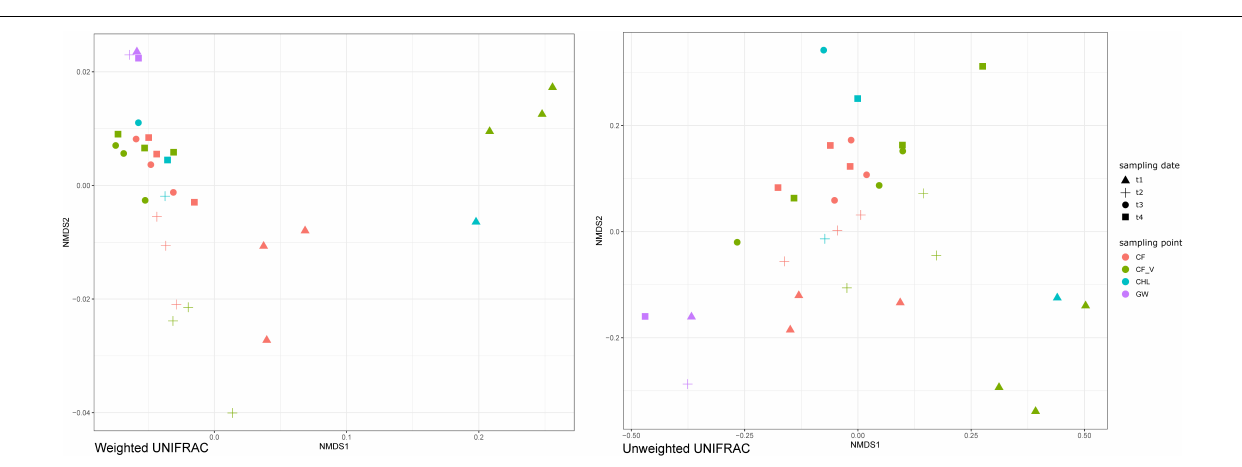
FIGURE 6 | NMDS based on weighted and unweighted UniFrac distance metric. Water samples were colored by sampling point (GW: groundwater; CF: mineral GACs; CF_V: vegetal GACs; BULK: downstream GACs samples); shapes indicate sampling date